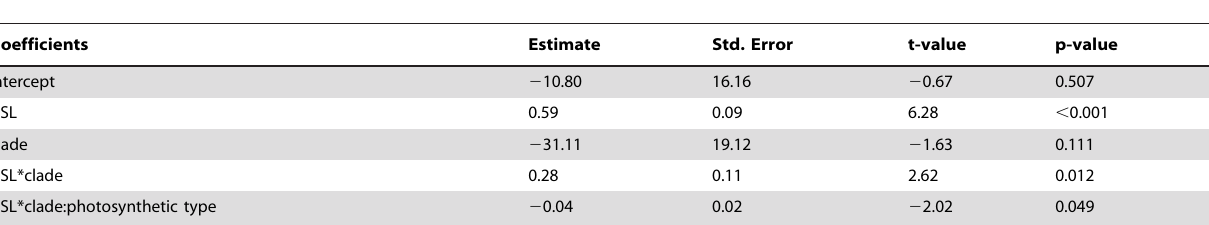
Table 2. The relationship between growing season length (GSL) and productivity (GSP) (Model D in Table 1) was marginally different between C 3 PACMAD and C 4 grasses (GSL*clade:photosynthetic type), and significantly different between clades irrespective of photosynthetic type (GSL*clade). See Figure